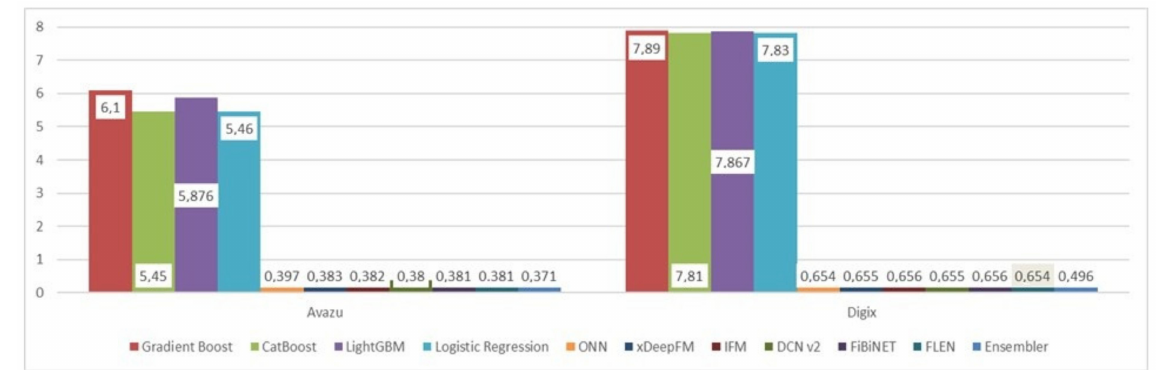
Figure 2. Log-loss scores for models regarding Avazu and Digix